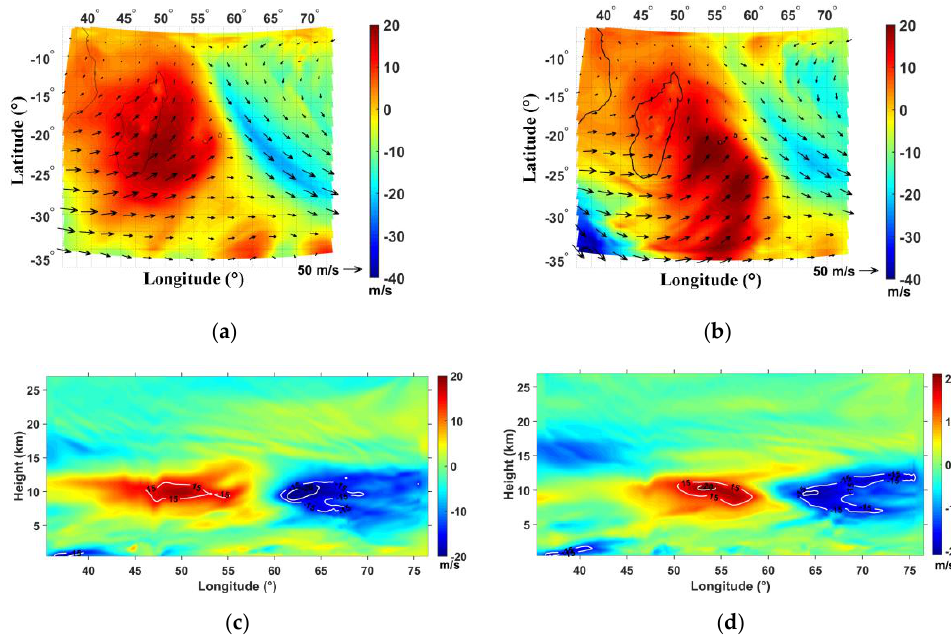
Figure 16. Meridional wind intensity (m/s) and wind direction (arrows) at 10 km height on ( a ) 9 October at 1200 UTC, ( b ) 10 October 0600 UTC; Longitudinal cross sections of meridional wind intensity (m/s) along the latitude of 21°S on ( c ) 9 October at 1200 UTC and ( d ) 10 October 0600 UTC. The northward and southward jets at 10 km height are colored in red and blue, respectively, with white contours.